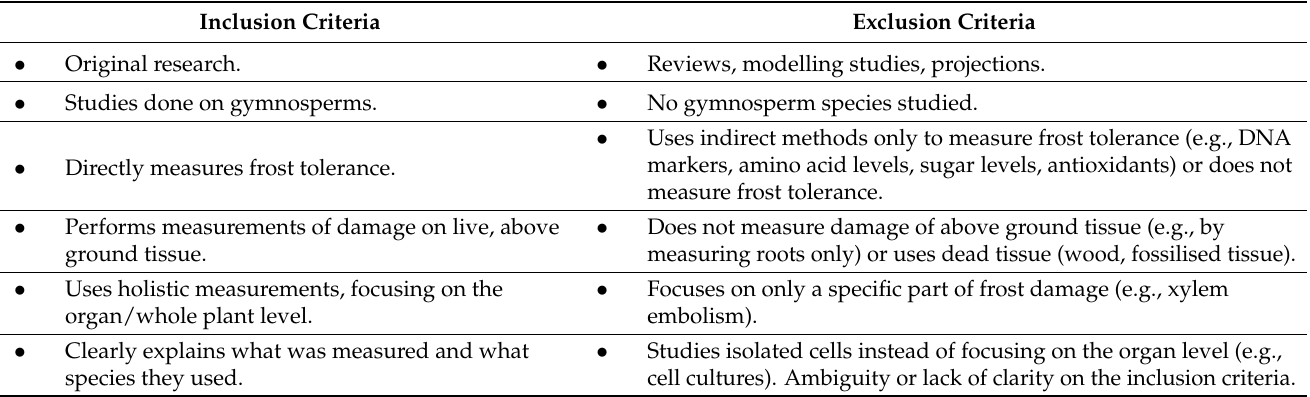
Table 2. Inclusion and exclusion criteria for entries to be included in the systematic map (decided a priori). Inclusion Criteria Exclusion